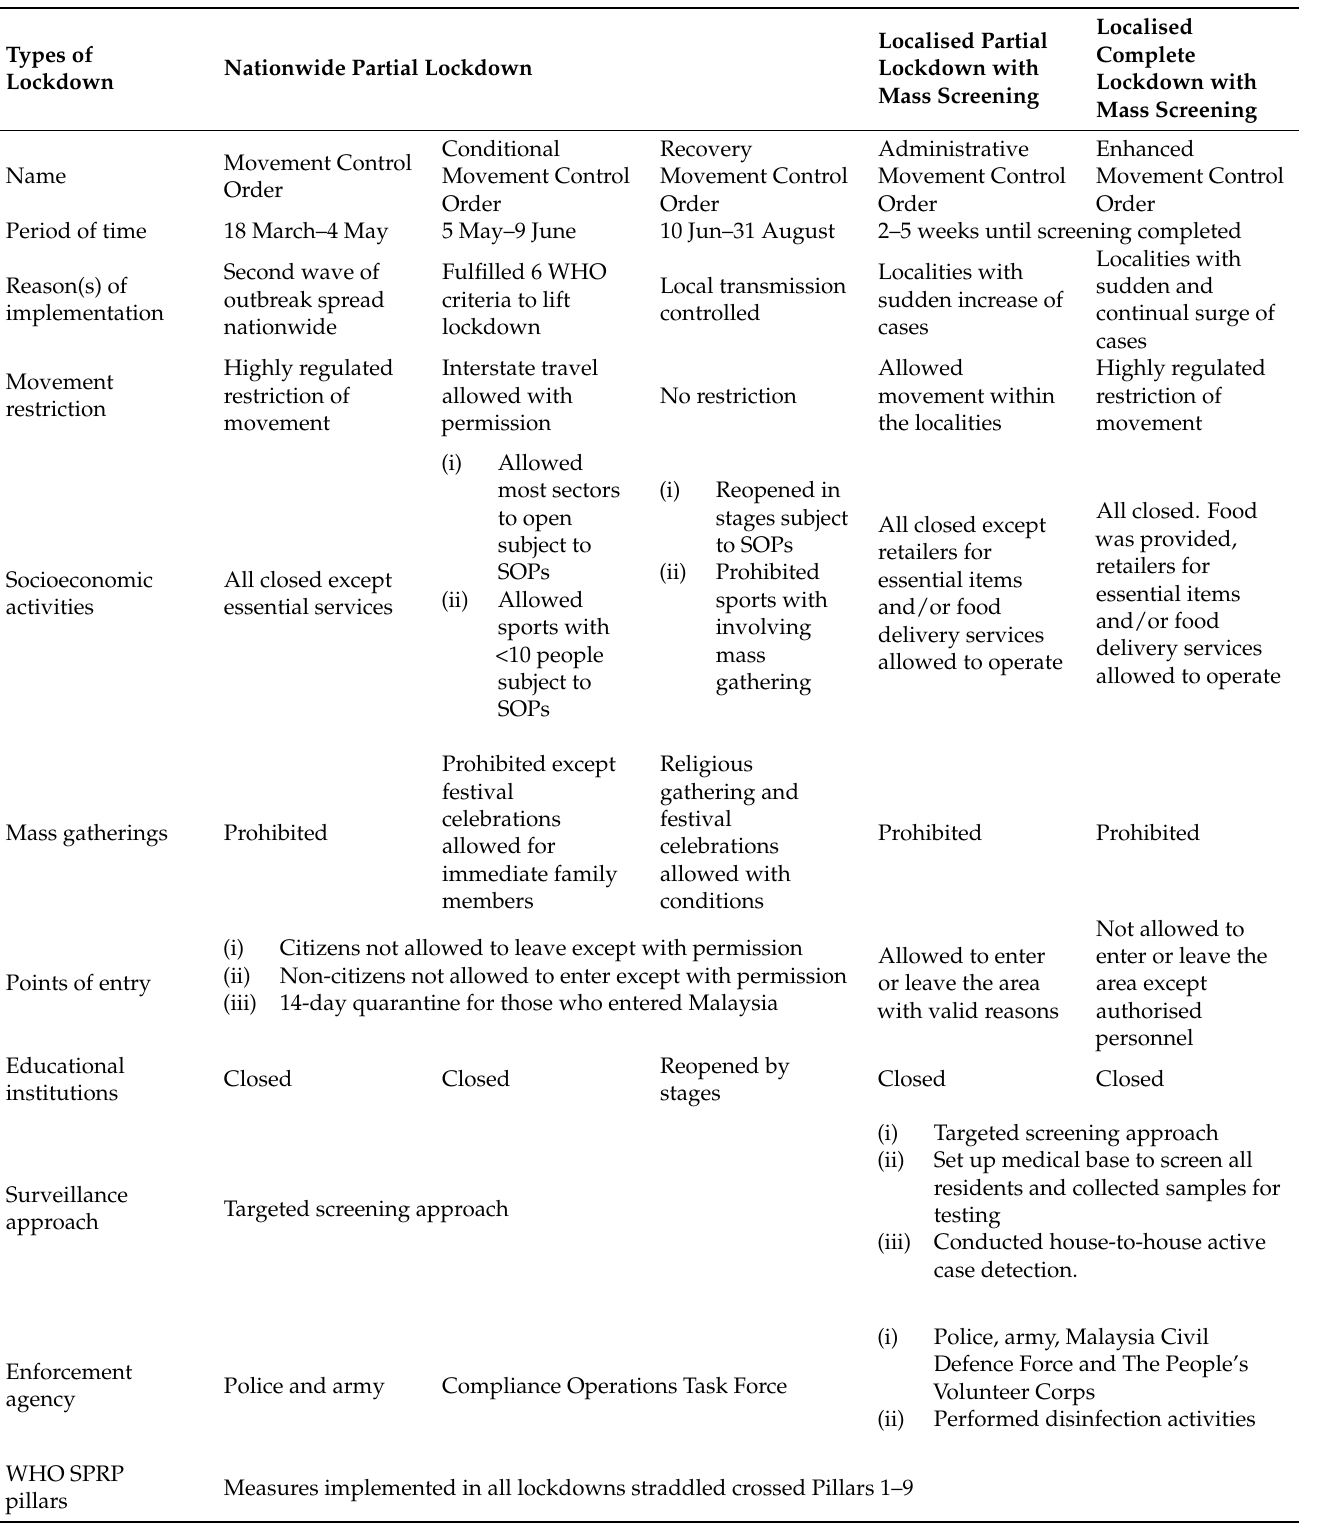
Table 1. Types of cordon sanitaire/lockdowns implemented by